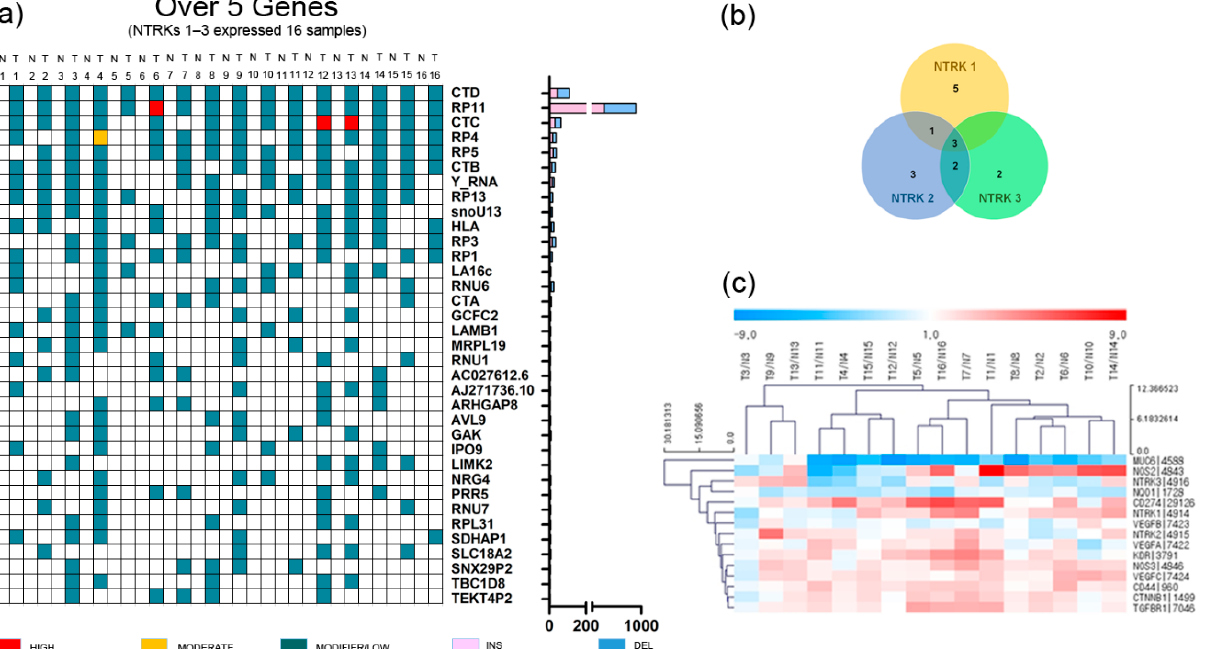
Figure 1. Gene alteration landscape of gastric cancer patients with amplification of neurotrophic tropomyosin receptor kinases. ( a ) Somatic indel of gastric cancer patients with amplification of neurotrophic tropomyosin receptor kinases (top 35 genes). T, tumor tissue; N, normal tissue. ( b ) Venn diagram of gastric cancer patients with amplification of neurotrophic tropomyosin receptor kinases, and ( c ) heatmap of gastric cancer patients with amplification of neurotrophic tropomyosin receptor kinases.